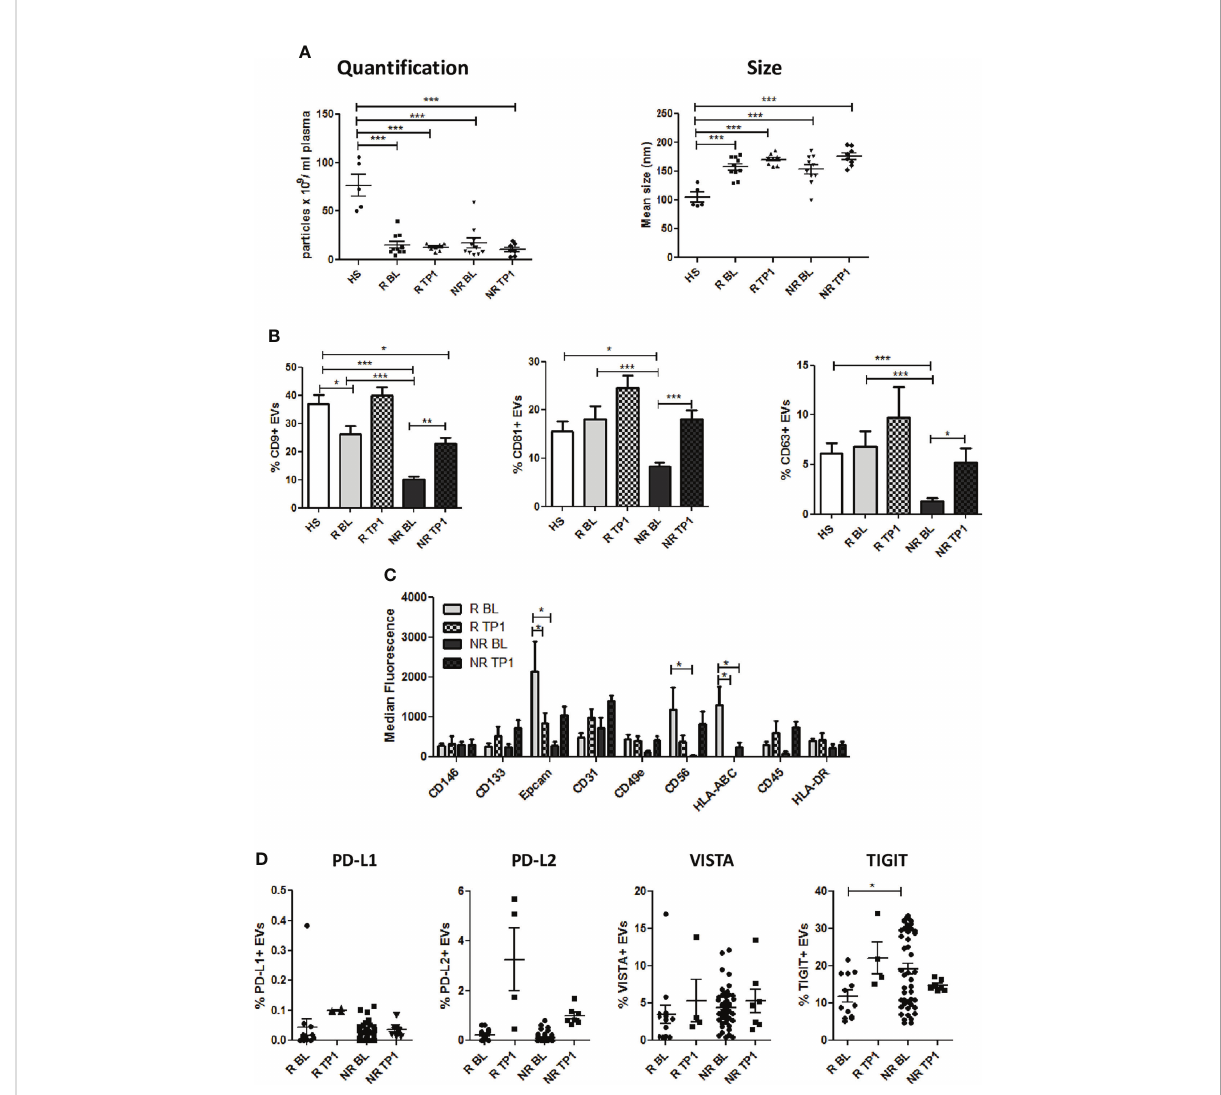
FIGURE 3 Characterization of plasma EVs from NSCLC patients during therapy. (A) Concentration and size distribution of EVs from R and NR patients, collected during ICI therapy, and heavy smokers (HS) healthy controls, using NTA (n = 8 per group). (B) Flow cytometric analysis of CD63, CD81, and CD9 EV markers during therapy on R and NR-EVs (R BL n = 13; R TP1 n = 4; NR BL n = 51; NR TP1 n = 7) (C) Surface EVs ’ markers pro fi les determined by MACSPlex Exosome Kit in R and NR-EVs patients. The values are the median fl uorescence intensities (R BL n = 8; R TP1 n = 6; NR BL n = 10; NR TP1 n=6). (D) Surface levels of of PD-L1, TIGIT, PD-L2 and VISTA in EVs collected pre- and after 1 st treatment from R and NR patients (R BL n = 13; R TP1 n = 4; NR BL n = 51; NR TP1 n = 7). The data are expressed as the mean ± S.E.M. (*p < 0.05; **p < 0.01; ***0.001 < p <